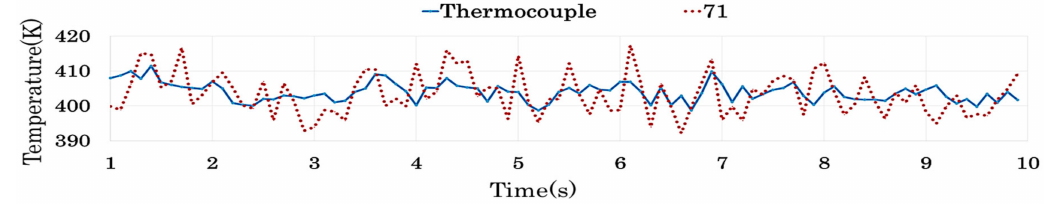
Figure 9. Comparison of T Thc and T Rec for 71 cycles.